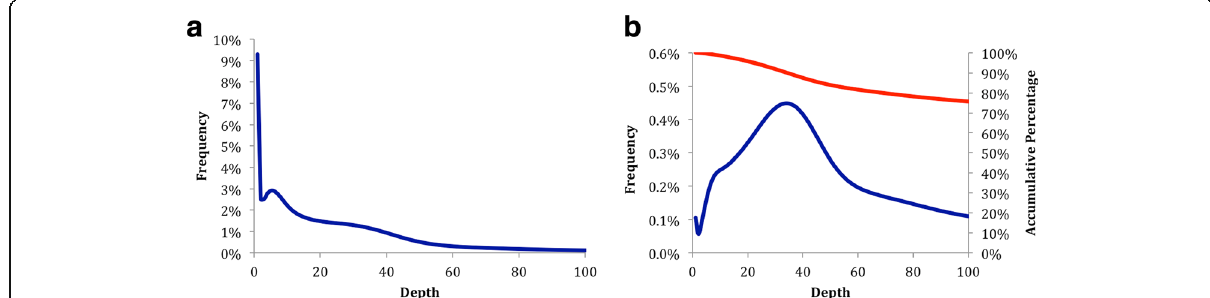
Fig. 1 Kmer (k = 17) frequency analysis. a Kmer species frequency graph. The horizontal axis shows the depth of kmer species, and the vertical axis shows the percentage of each kmer species value (blue curve). b . Kmer individuals frequency graph. The horizontal axis shows depth of kmer individuals, the left vertical axis shows the percentage of each kmer individual ’ s value (blue curve), and the right vertical axis shows the accumulative frequency of the kmer individuals (red curve)